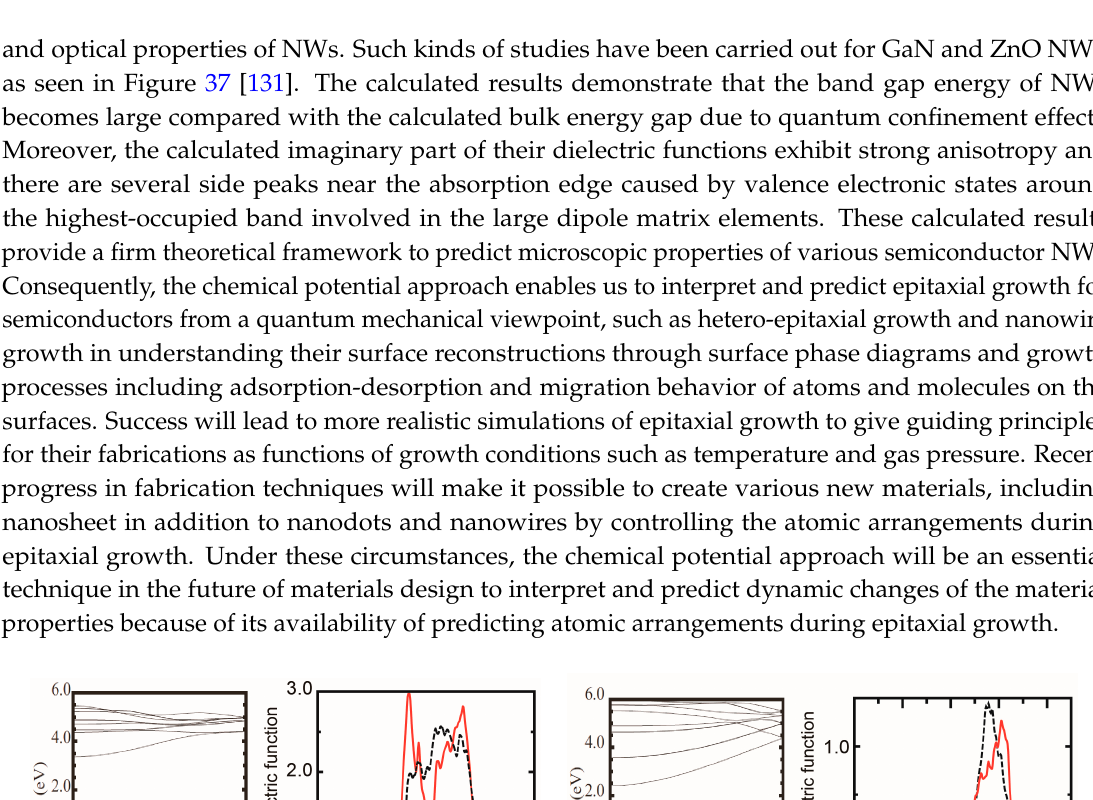
Figure 36. Surface phase diagrams for H-adsorbed ( a ) AlN and ( b ) GaN with different orientations as functions of temperature and pressure.